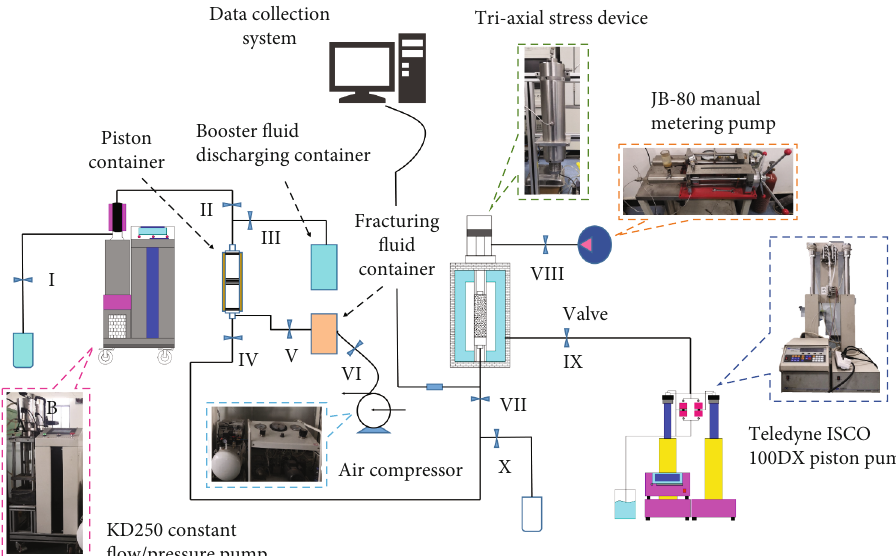
Figure 4: Schematic diagram of the hydraulic fracturing experimental system.